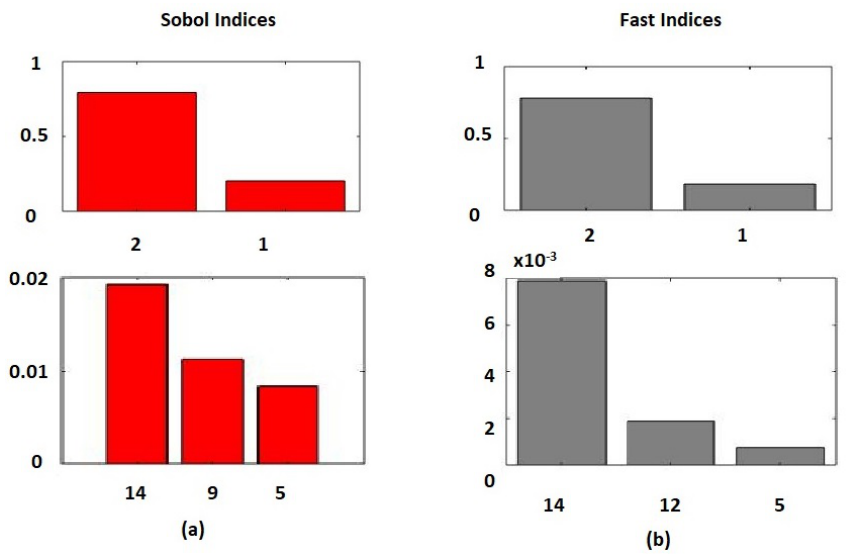
Figure 6. Sobol and FAST sensitivity indices of carbon monoxide.